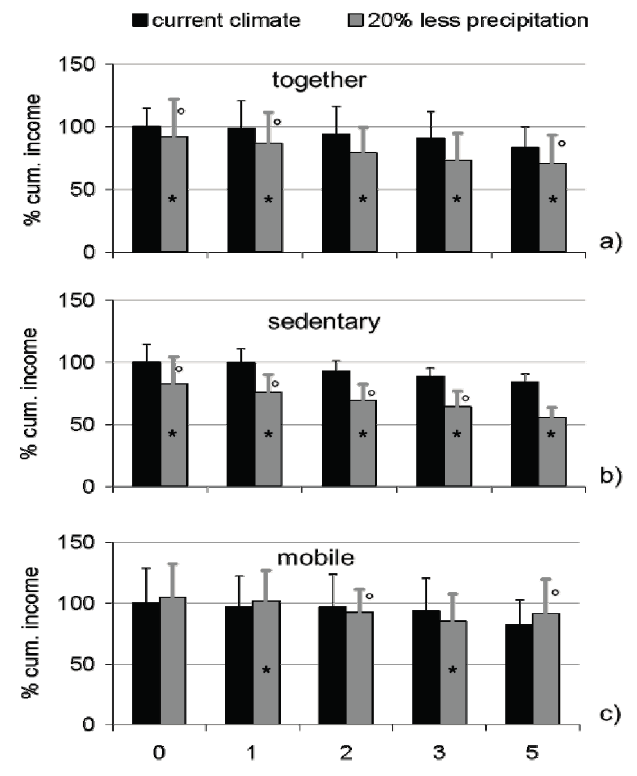
Figure 7. Modeled 15-years cumulative income from pastoralism relative to present-day conditions with different occurrences of droughts. ( a ) the whole pastoral system; ( b ) income from sedentary pastoralism; ( c ) income from mobile pastoralism. * significant differences of means ( p < 0.05); ° significant differences of standard deviations ( p <